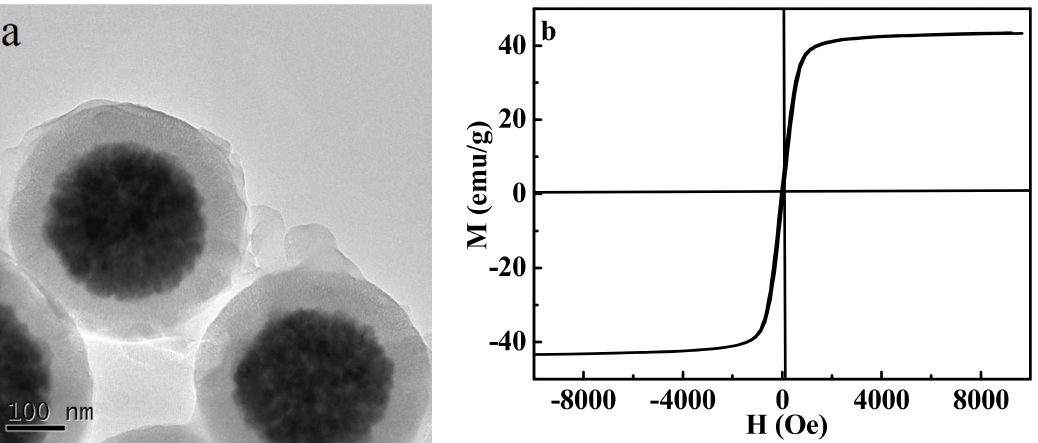
Figure 2. TEM image ( a ) and hysteresis loop ( b ) for